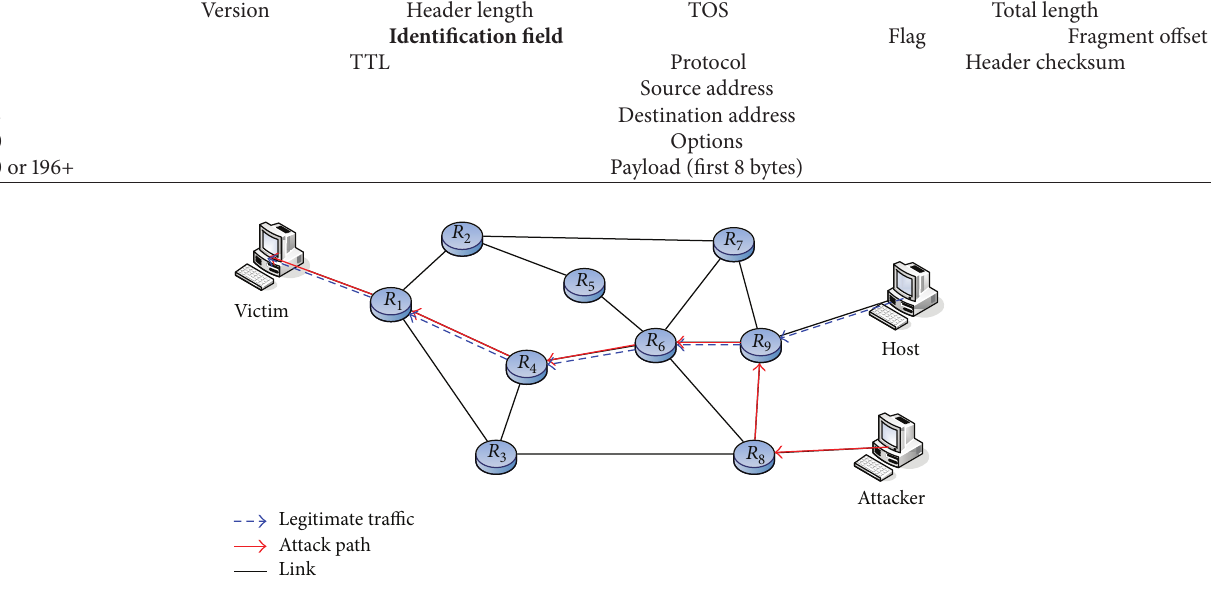
Figure 2: Network